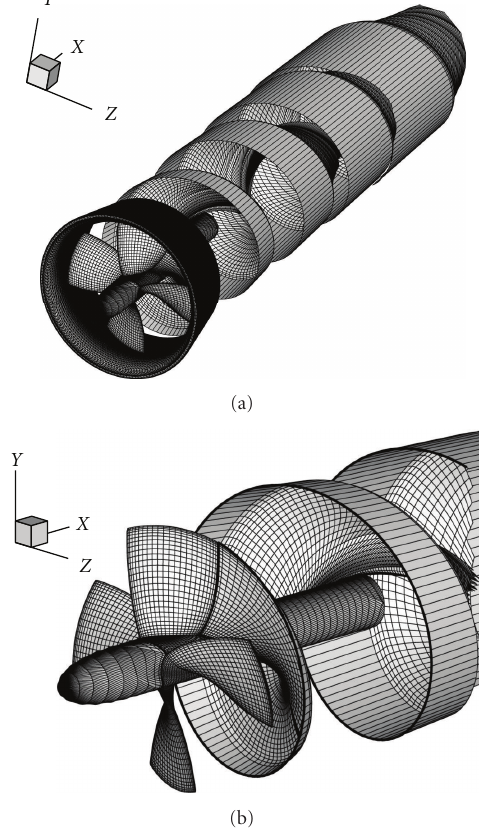
Figure 9: Panel arrangement for propeller Ka4-70 inside duct 19Am at J = 0 . 5. Gap model with transpiration velocity. Wake alignment model with duct boundary layer correction. The duct grid is not shown in the bottom